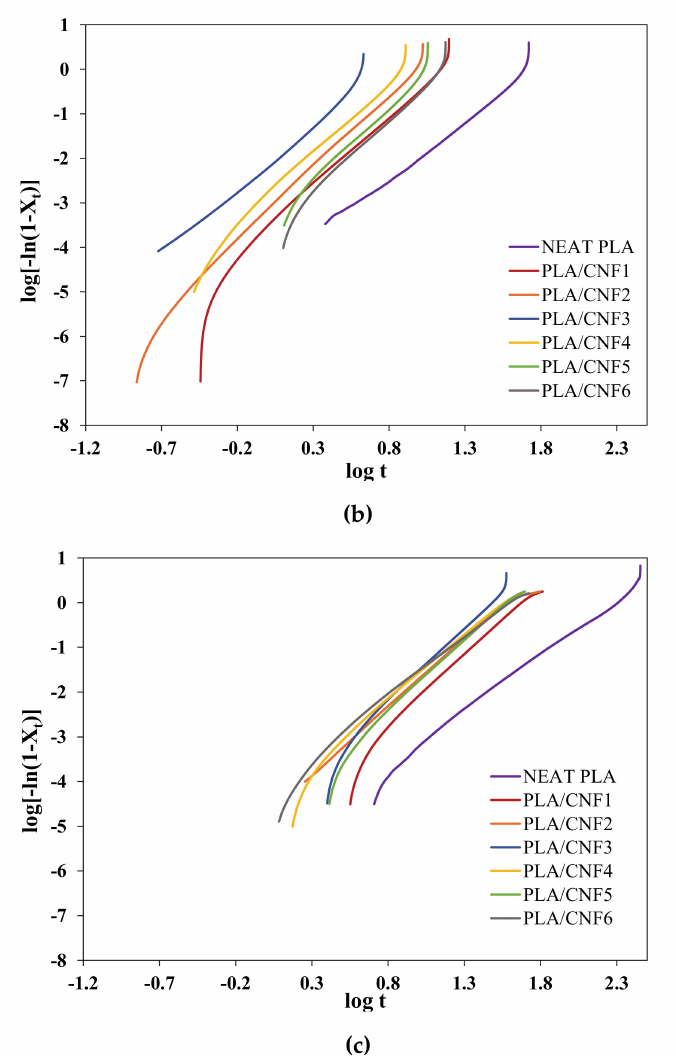
Figure 4. Avrami plots of neat PLA and PLA/CNF nanocomposites isothermally crystallized at ( a ) 90, ( b ) 100, and ( c ) 110 ◦